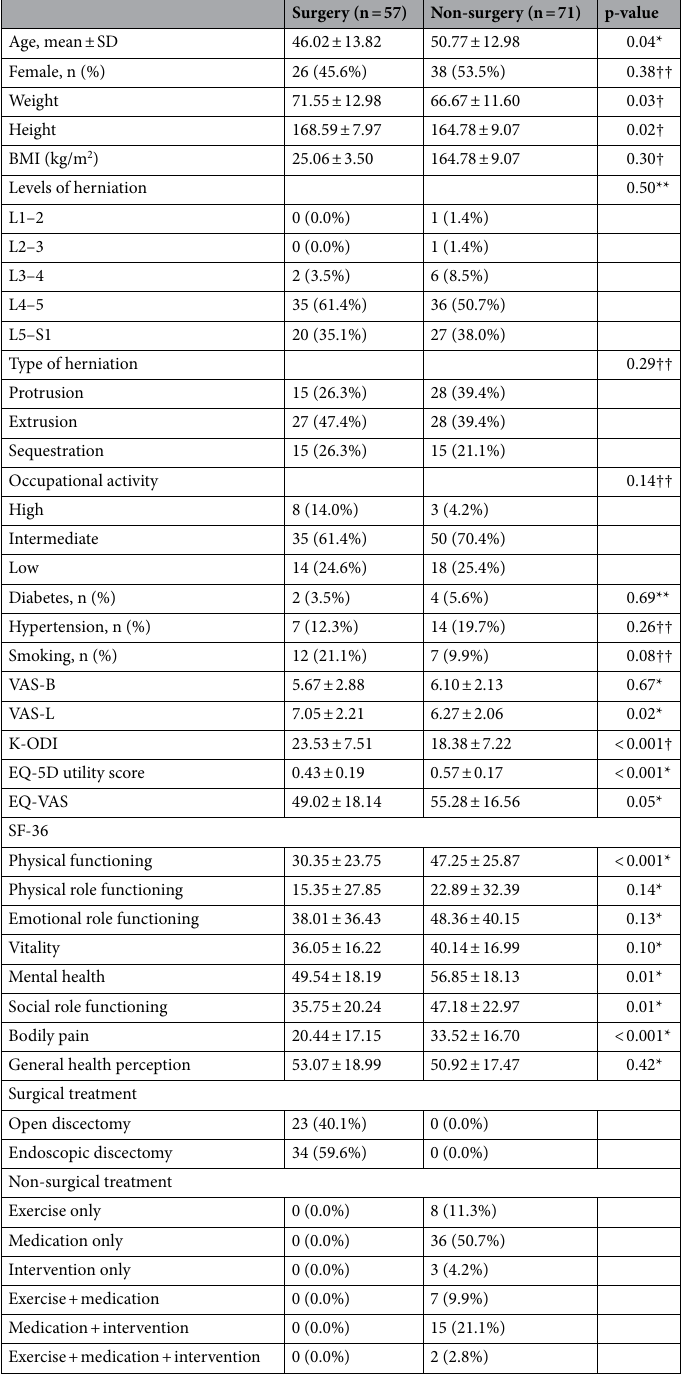
Table 2. Characteristics of cohorts. BMI body mass index, VAS-B visual analogue scale for back pain, VAS- L visual analogue scale for leg pain, K-ODI Korean version of the Oswestry Disability Index, EQ-5D